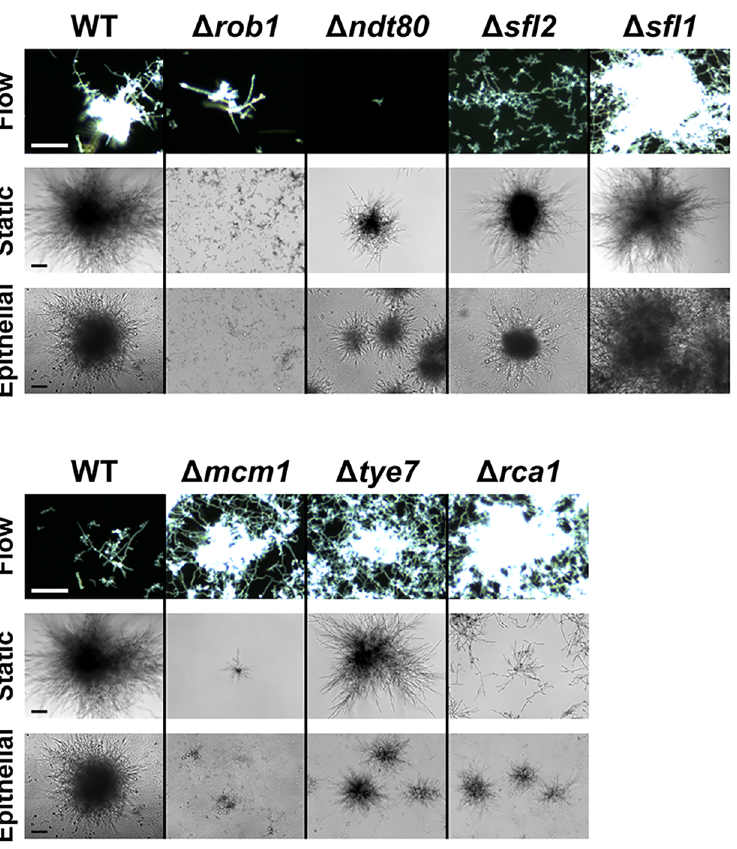
Fig 5. Candidaalbicans transcriptional regulator knockouts Δ rob1 , Δ ndt80 ,and Δ sfl1 showed microcolony formation defects. Candida albicans wild-type (WT) cells and seven transcriptional regulator knockouts were evaluated for their microcolony formation using flow assay, and static plate assays (RPMI and 5% CO 2 ) on both plastic and epithelium. Flow microcolonies were imaged using time-lapse microscopy. Flow sample images show results at 18 h (WT [top], Δ rob1 , Δ ndt80 ,and Δ sfl1 ),8 h (WT [bottom], Δ mcm1 , Δ tye7 ,and Δ rca1 ), and 24 h ( Δ sfl2 ).Static microcolonies were grown for 24 h prior to imaging. Microcolonies that showed consistent differences in both static and flow conditions when compared to WT are on the top row, with most showing reduced microcolony formation (except Δ sfl1 that had larger microcolonies). The three remaining mutants (bottom row) had inconsistent results between static and flow conditions, with flow microcolonies being more dense and static microcolonies being reduced in size. Scale bars indicate 100 μ